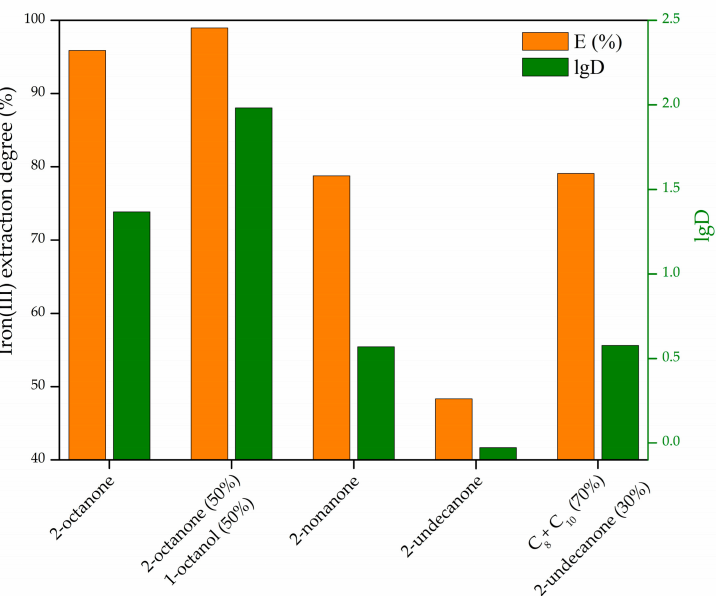
Figure 7. The dependence of iron(III) extraction degree (E) and distribution ratio (D) on the oxygen- containing extractant from bauxite leaching solution at C(HCl) = 6 M, C(Fe) = 9.7 g/L, O:A = 1:3.